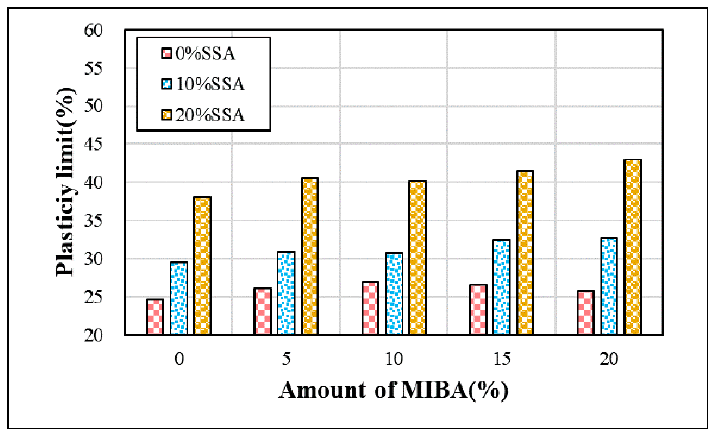
Figure 3. Plasticity limits of the specimens.